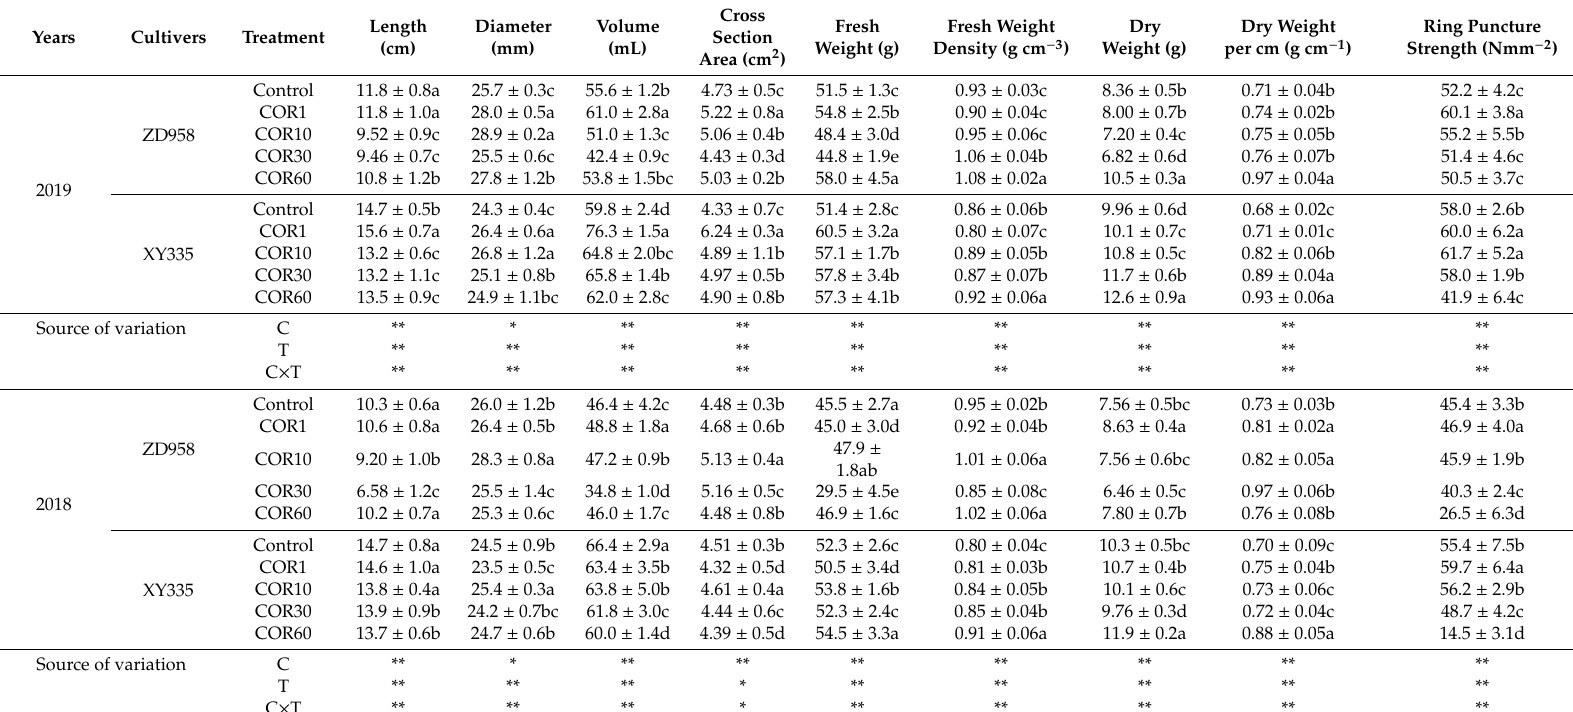
Table 1. E ff ects of COR on the morphological characteristics and physical strength characteristics of the third basal internode in 2018 and